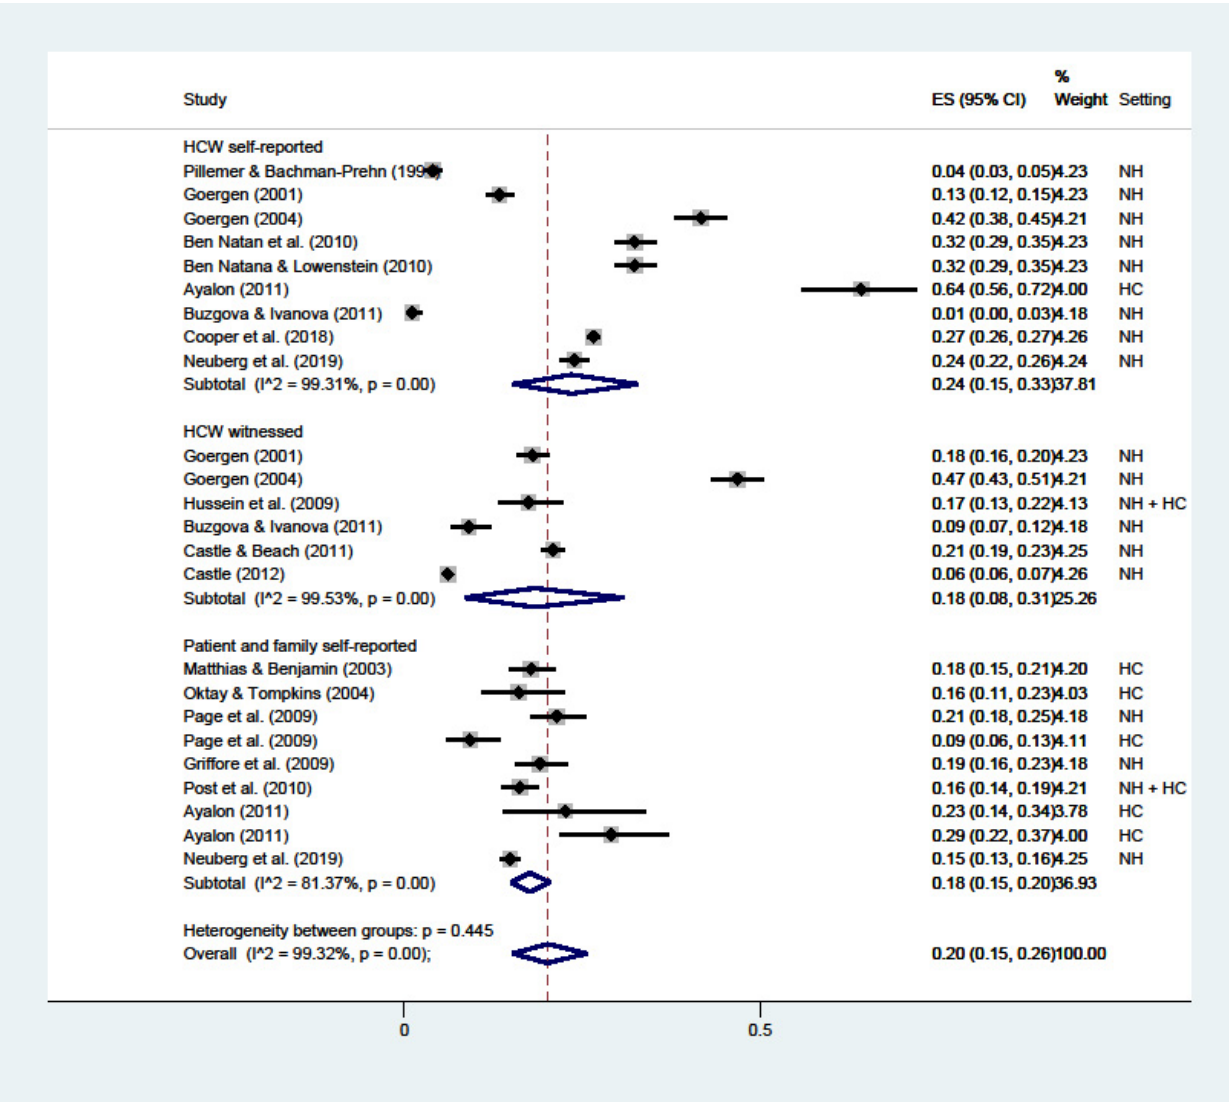
Figure 7. Forest plot of the prevalence of neglect in LTC. Subgroup meta-analyses by (Healthcare workers (HCW) self-reported, HCW witnessed, or patient and family self-reported). NH: nursing home; HC: home care.